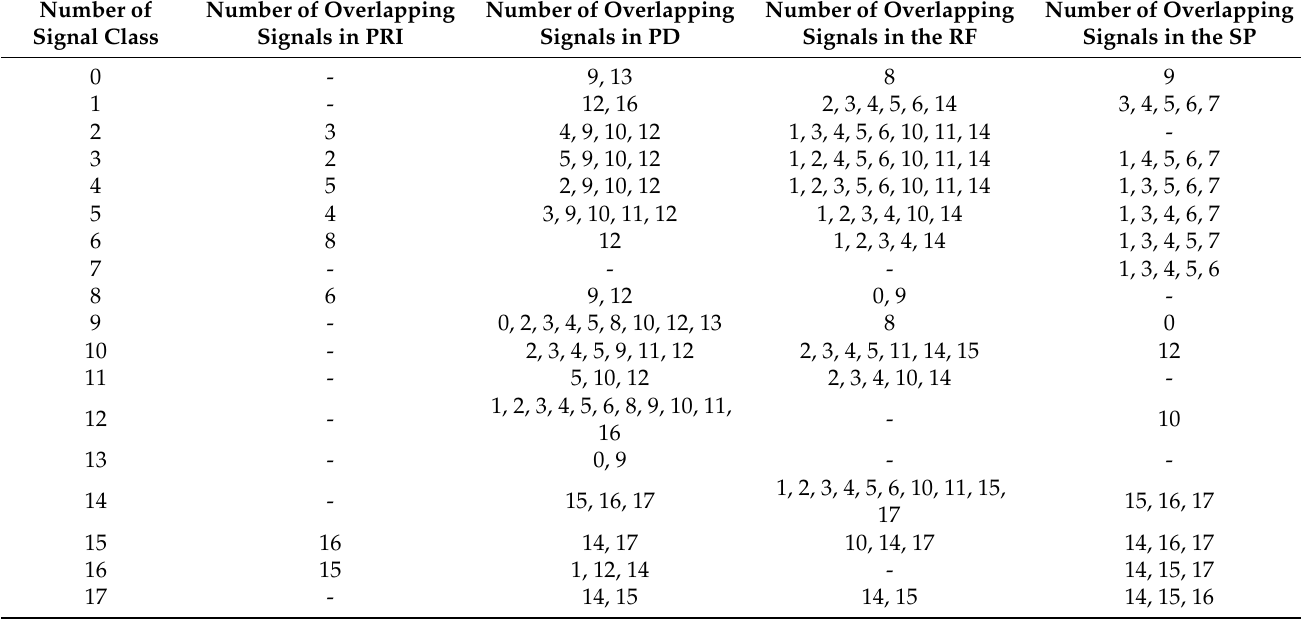
Table 2. Overlapping of individual signals in PRI, PD, RF and SP